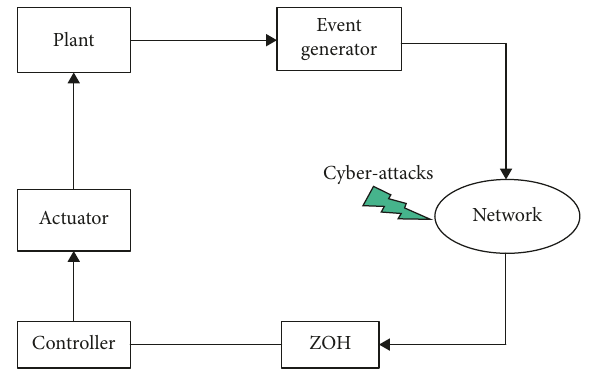
Figure 1: Framework of event-triggered control for CPSs against